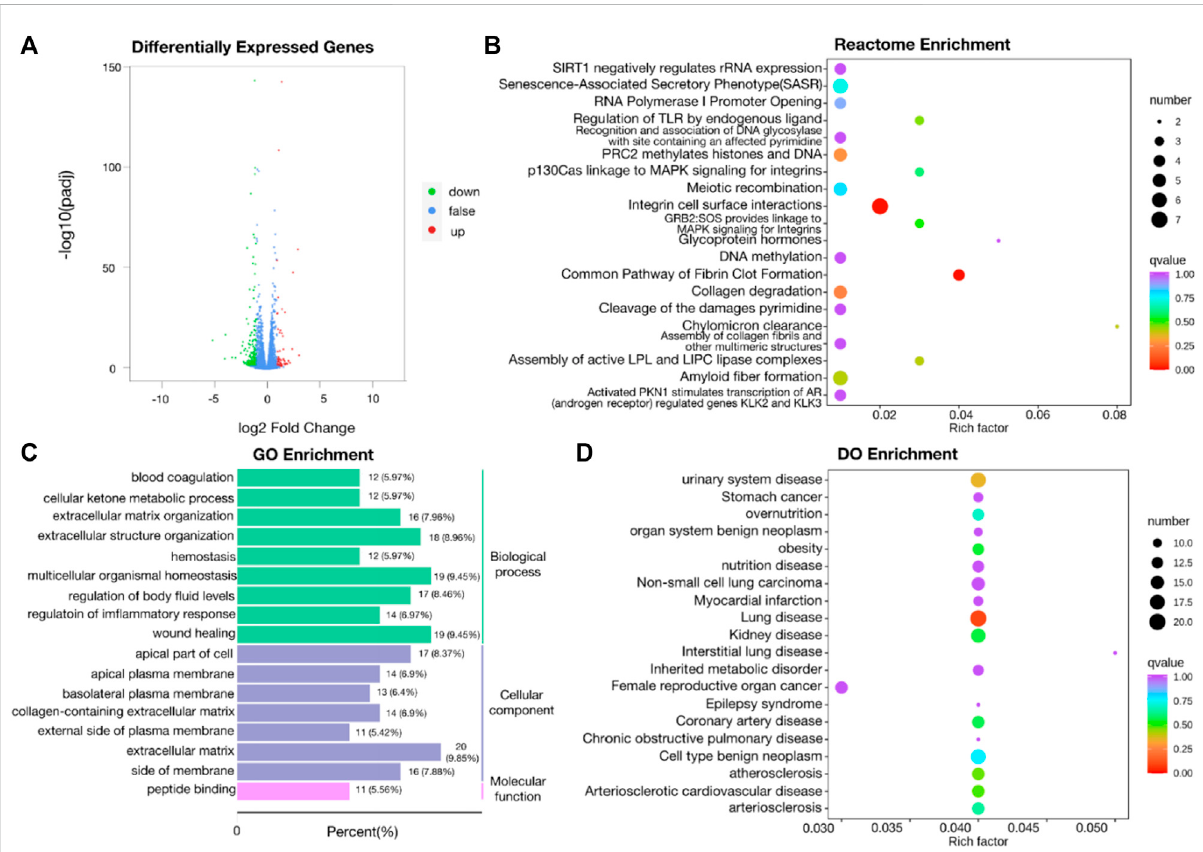
FIGURE 1 Transcriptomic analysis of SLC39A1-Overexpressed OSRC-2 cells. (A) The Volcano plot of differentially expressed genes. The Y -axis displays -log10 (p-adj) and the X -axis the log2 fold change of DEGs. Green dots indicate downregulated genes, and red dots indicate upregulated genes. (B) Gene Ontology enrichment analysis. Green bars indicate biological process (BP) category, purple bars indicate cellular component (CC) category and pink bars molecular function (MF) category. (C) Reactome enrichment analysis of transcriptomic data. (D) Disease Ontology (DO) enrichment analysis of transcriptomic